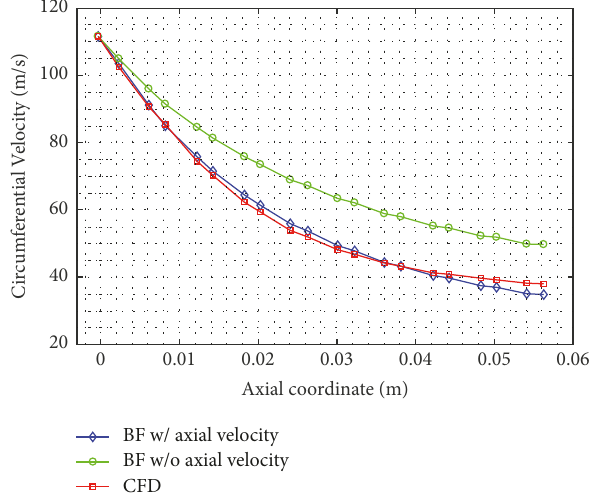
Figure 20: Circumferential velocity as a function of the axial coordinate for case 1 shown in Table 2.